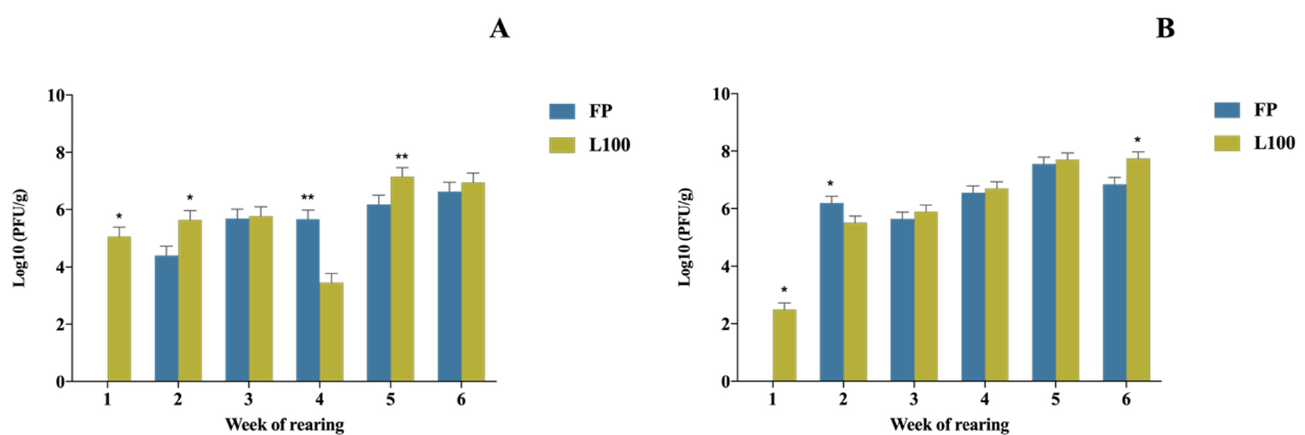
Figure 3. Concentration of the BPs recovered following administration depending on the week of application and organ analysed: ( A ) the gut and ( B ) the cecum. Values are presented as Log10 (PFU/g). The statistically significant differences between groups comparing BP delivery method have been represented as * ( p -value < 0.05) and ** ( p -value < 0.001).